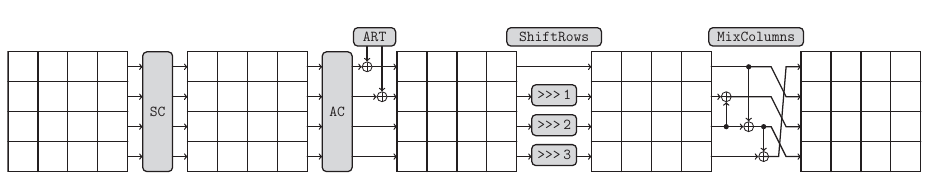
Figure 2: SKINNY cipher, operations of an encryption round [BJK +